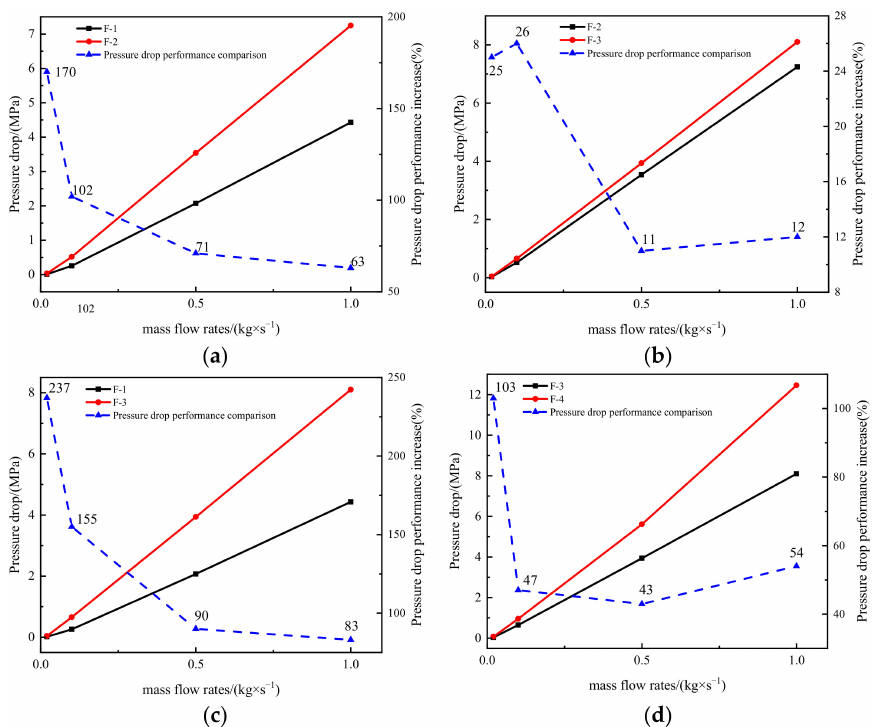
Figure 18. Comparison of pressure reduction performance of four structures. ( a ) F-1 and F-2 pressure reduction. ( b ) F-2 and F-3 pressure reduction. ( c ) F-1 and F-3 pressure reduction. ( d ) F-3 and F-4 pressure